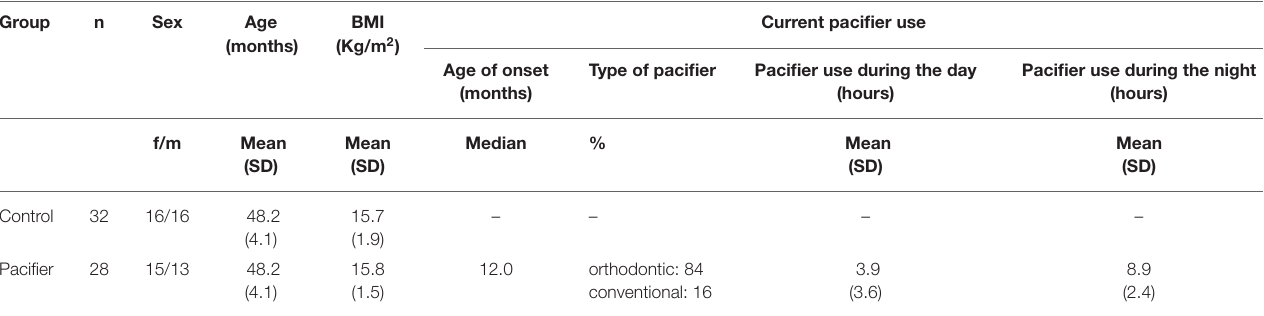
TABLE 1 | Demographic and clinical characteristics of groups at